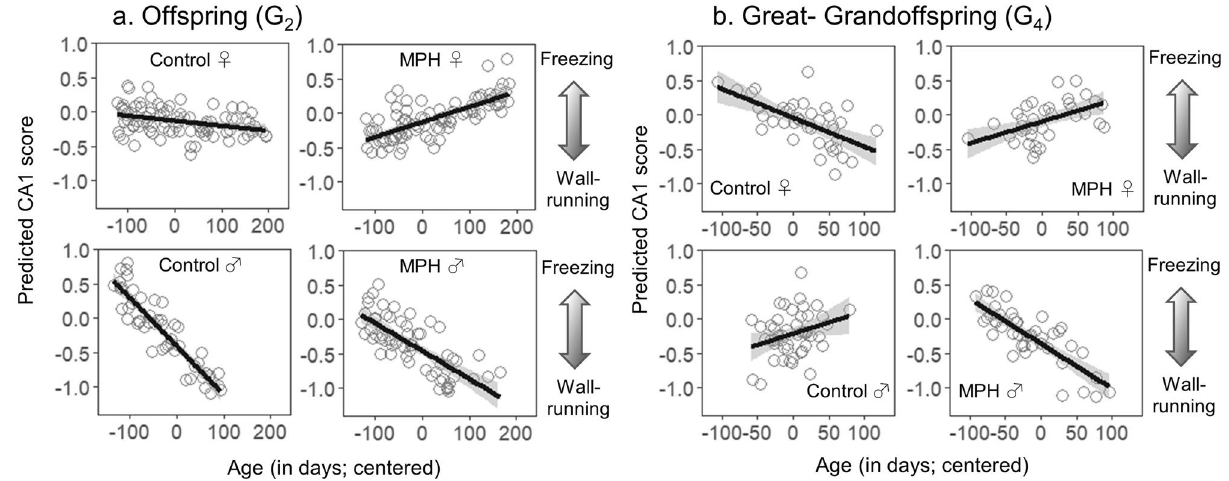
Figure 3. Associations between age and CA1 scores in the open field test for offspring (G 2 ; panel a ) and great- grandoffspring (G 4 ; panel b ). Panel ( a ): Male offspring of both Control (‘Control ♂ ’) and MPH treated (‘MPH ♂ ’) sires that were tested at a younger age froze relatively more than individuals tested at older ages. For female offspring of Control sires (‘Control ♀ ’), there was not an association between age and CA1 score but, in contrast, female offspring of MPH treated sires (‘MPH ♀ ’) froze more if tested at a relatively older age. Panel ( b ): All groups for the great-grandoffspring (G 4 ) cohort exhibited qualitatively similar patterns to the same groups from the G 2 cohort, except for male great-grandoffspring descended from G 1 Control males (‘Control ♂ ’); however, this difference was not statistically significant. Positive CA1 values indicate relatively more freezing and negative values indicate relatively more wall-running. Lines were fit to the predicted values (which incorporate model estimates and random effects) using ‘lm’ in R and shading corresponds to the 95% confidence intervals.